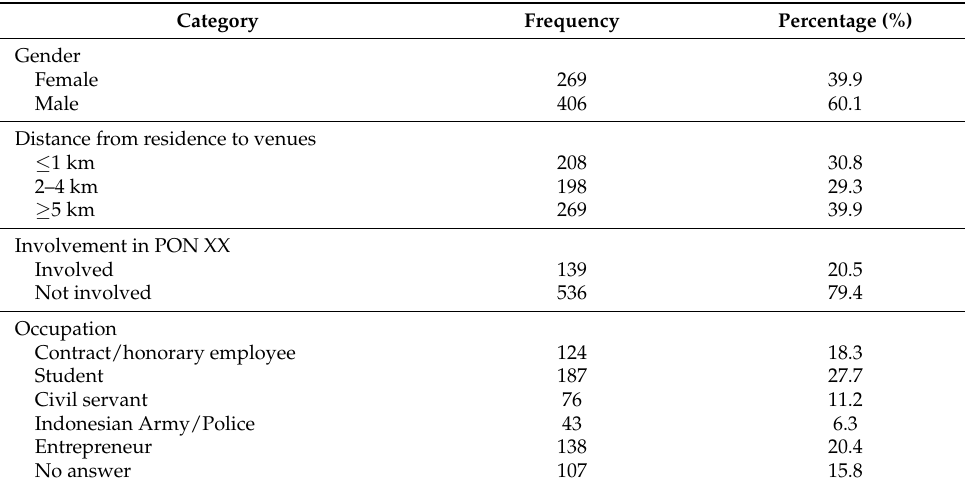
Table 1. Respondent demographics (n =